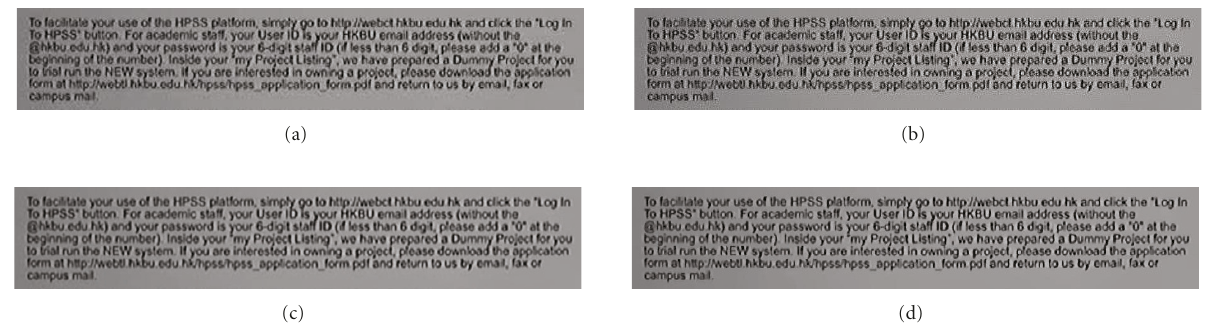
Figure 17: SR reconstruction results of the “bulletin” sequence. (a) LR frame, (b) Laplacian SR result with λ 2 = 0 . 001, (c) Laplacian SR result with λ 2 = 0 . 5, and (d) TV SR result with λ 2 = 5 . 0.